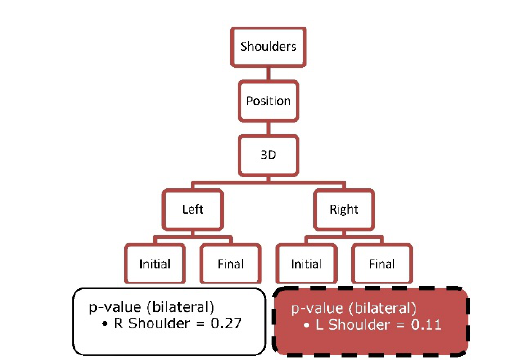
Figure 13 – Shoulders Student's paired t-test